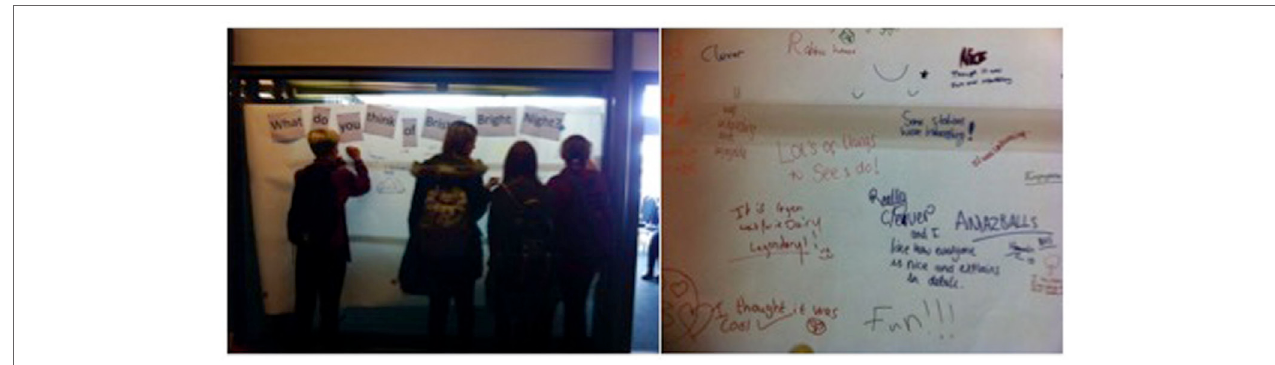
FigUre 1 | Graffiti wall at Bristol Bright Night (Sardo and Grand,